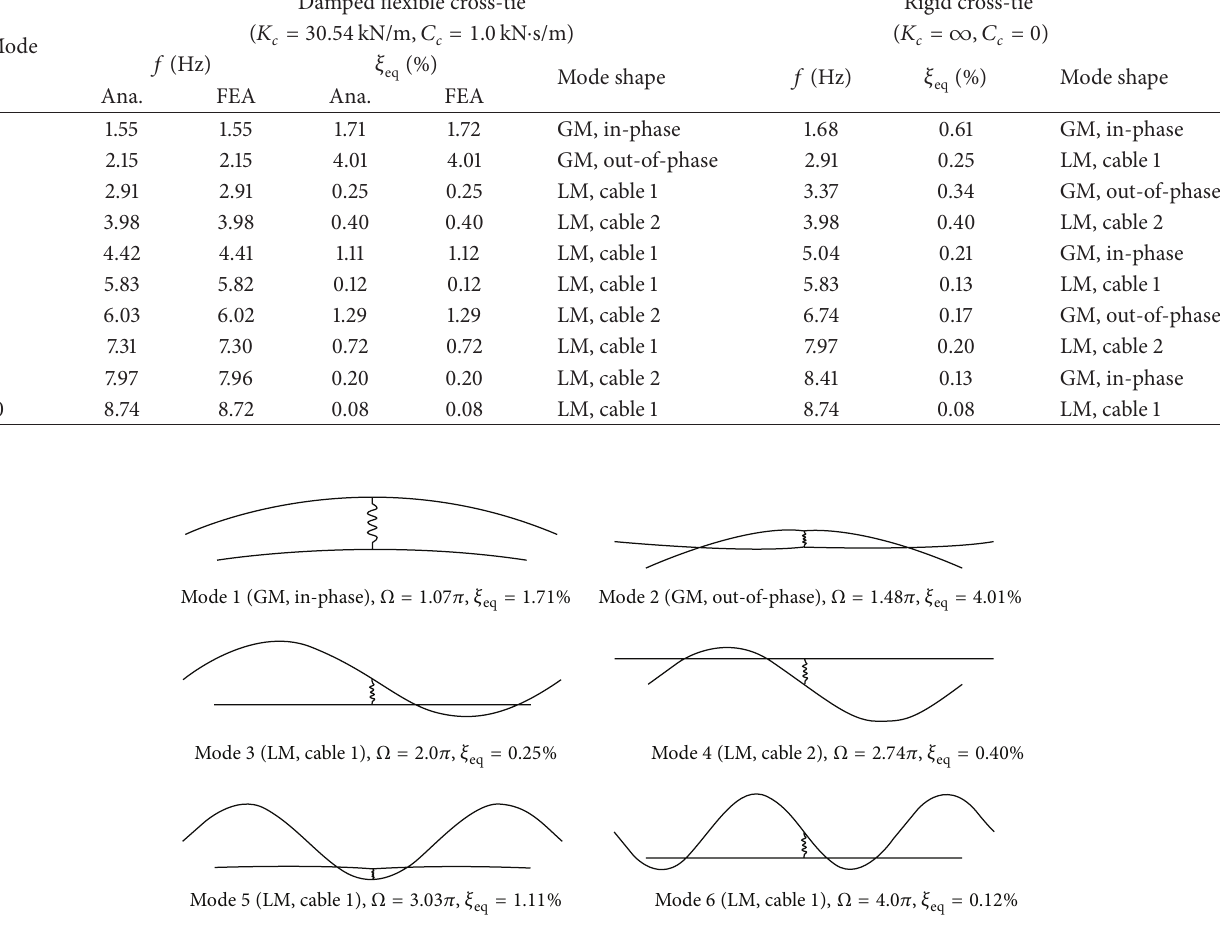
Table 3: Comparison of modal properties of a symmetric DMT two-cable network with damped flexible or rigid cross-tie at 𝜀 = 1/2 . Damped flexible cross-tie Rigid cross-tie Mode